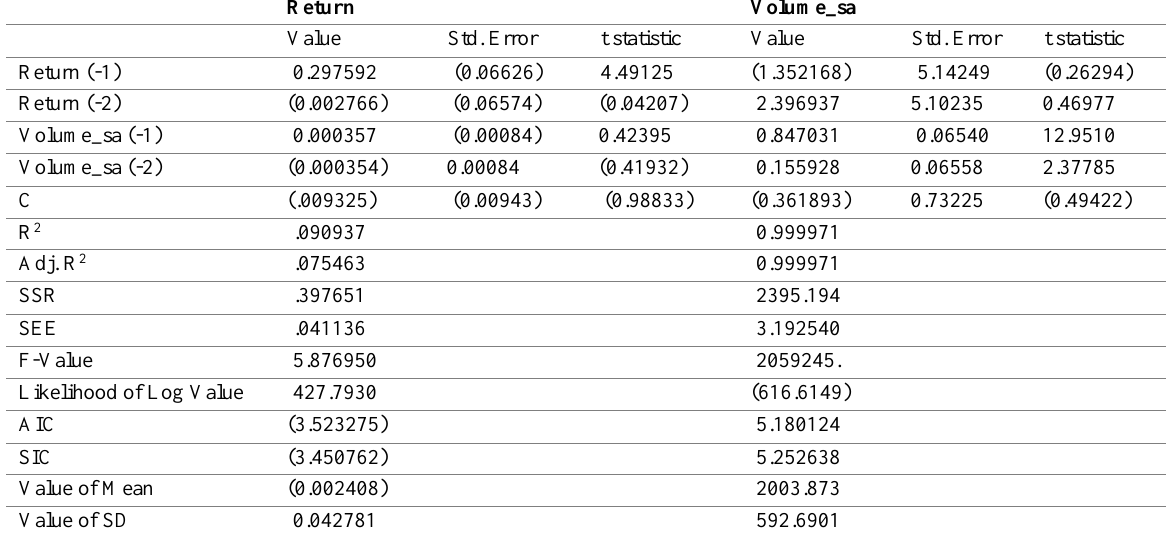
Table 5: Result of Panel VAR Between Return and Seasonally Adjusted Volumes of Stocks for Small Finance